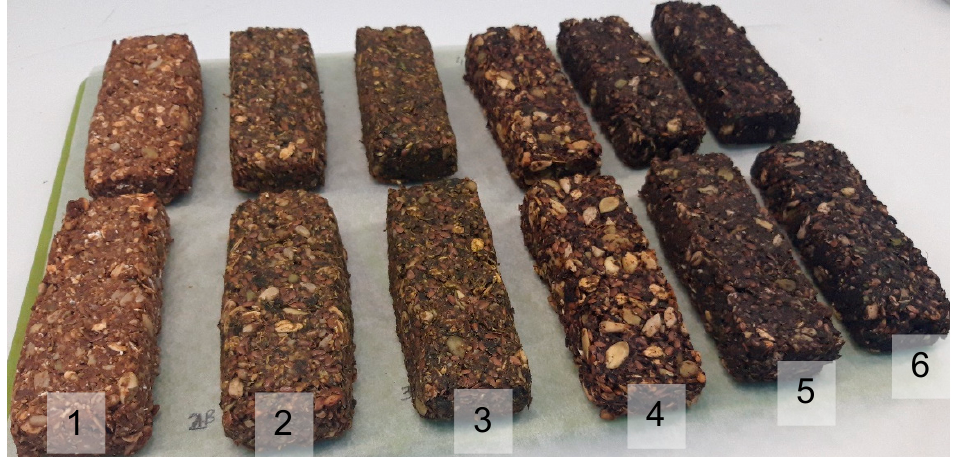
Figure 2. Pictures of baked bars, respectively: 1—base (Control), 2—with apple fibre and 20% kale, 3—with apple fibre and 30% kale, 4—with hibiscus fibre and 20% kale, 5—with fibre from blackcurrant and 20% kale, 6—with chokeberry fibre and 20% kale.